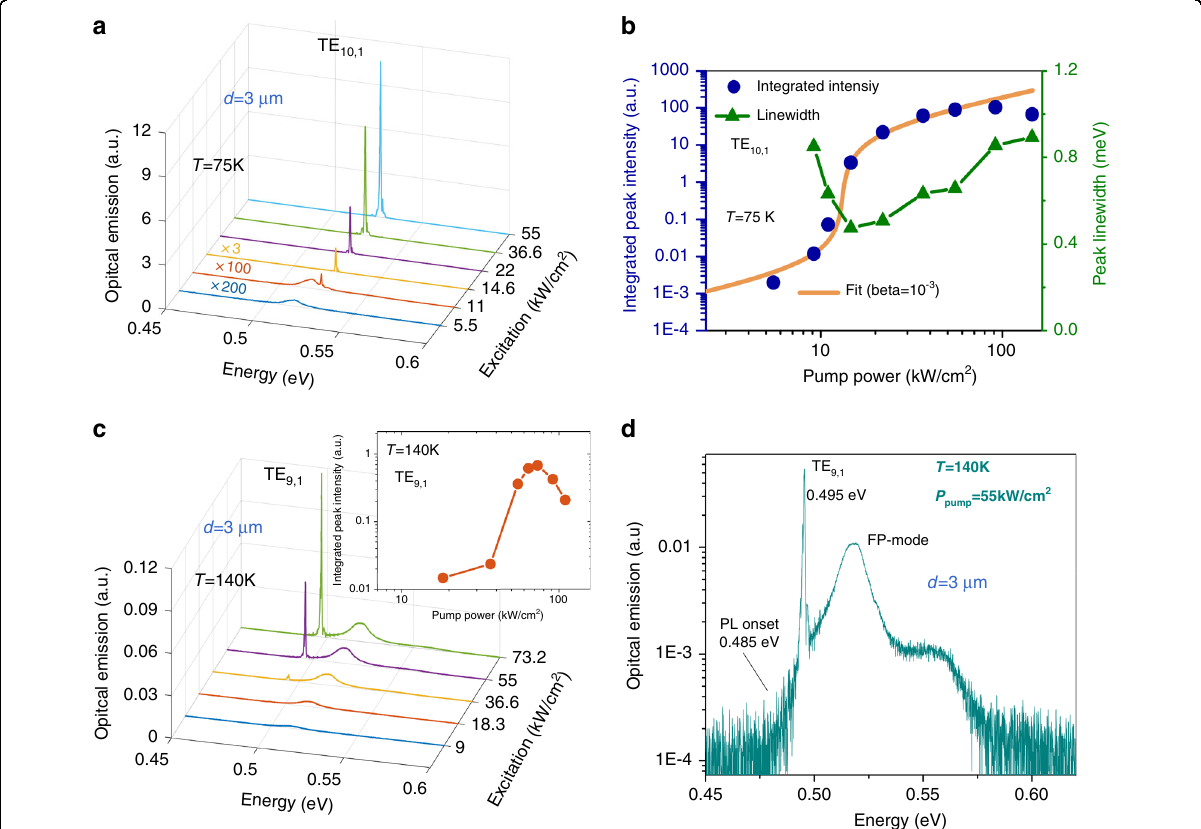
Fig. 5 Down-scaled GeSnOI mesa laser. a Pulsed PL spectra of 3 µm diameter GeSnOI mesa with 360-nm-thick GeSn under various excitation densities at 75 K. b the L – L curve of the laser mode TE 10,1 at 75 K in log – log scale and mode linewidth as a function of the pump power. c same as a at 140 K, the inset shows the L – L curve in a log – log scale for the lasing mode which is the TE 9,1 in this case. d Emission spectrum above threshold at 140 K highlighting the TE 9,1 lasing mode position with respect to the spontaneous emission. The spontaneous emission is itself strongly modulated by broad peak that stems from Fabry – Pérot (FP) resonance. These FP-modes emit more favorably out-of-plane and are thus better collected than the